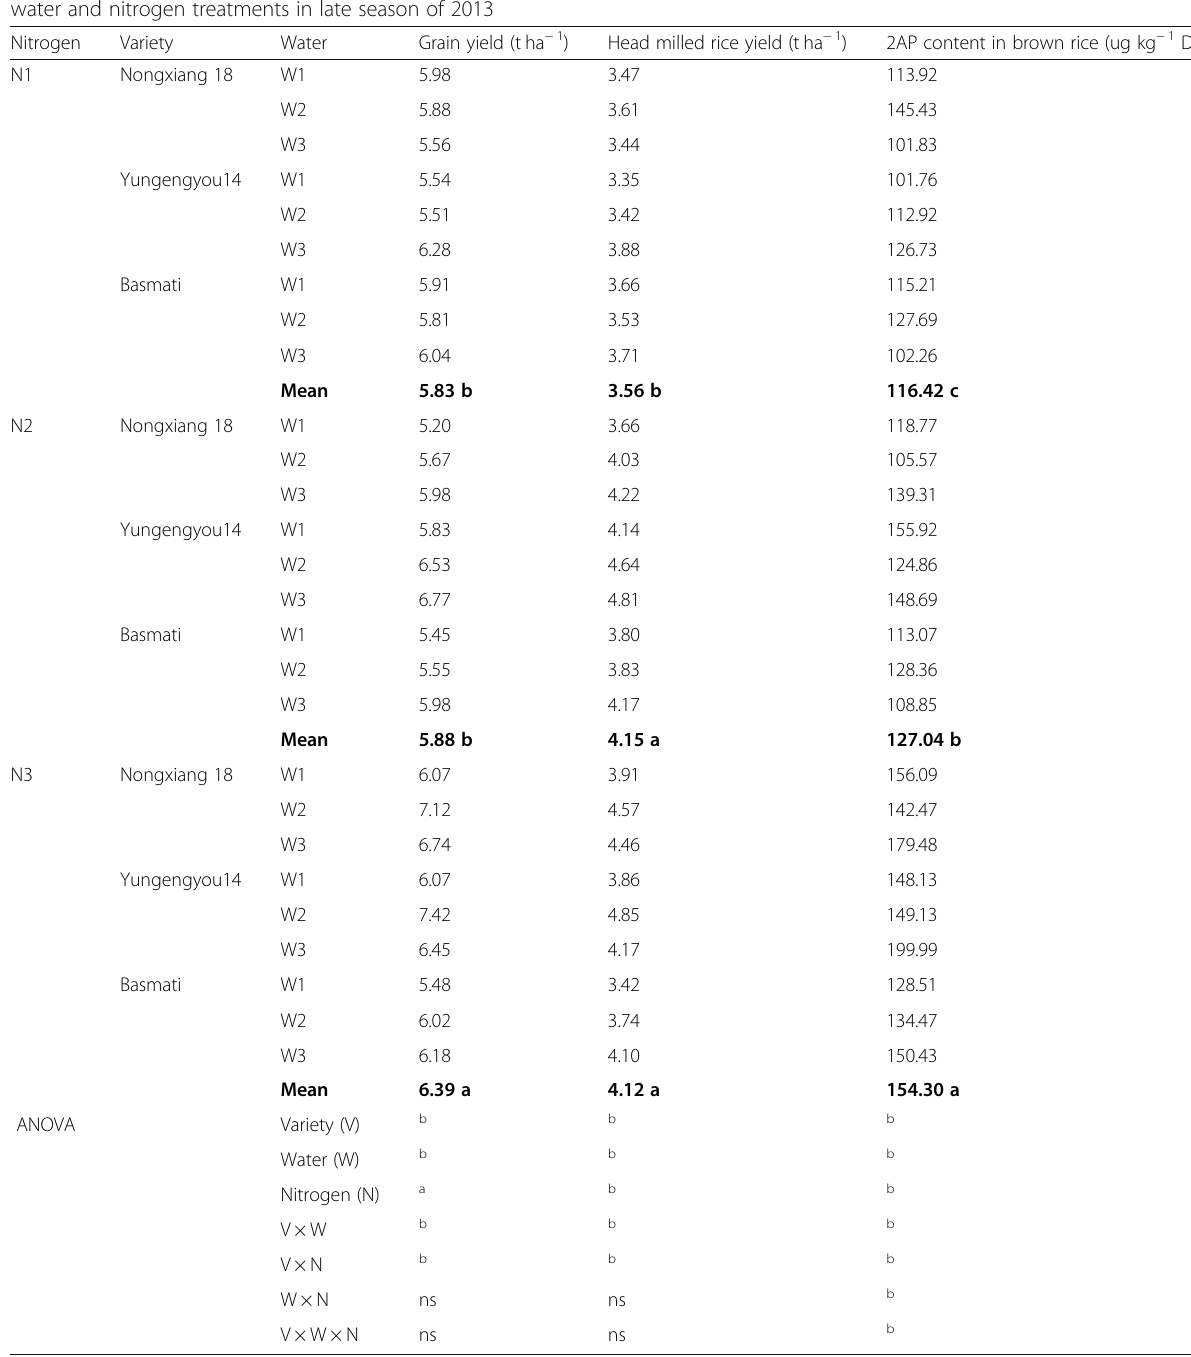
Table 4 Grain yield, head milled rice yield and 2AP content in brown rice of three fragrant rice varieties grown under different water and nitrogen treatments in late season of 2013 Nitrogen